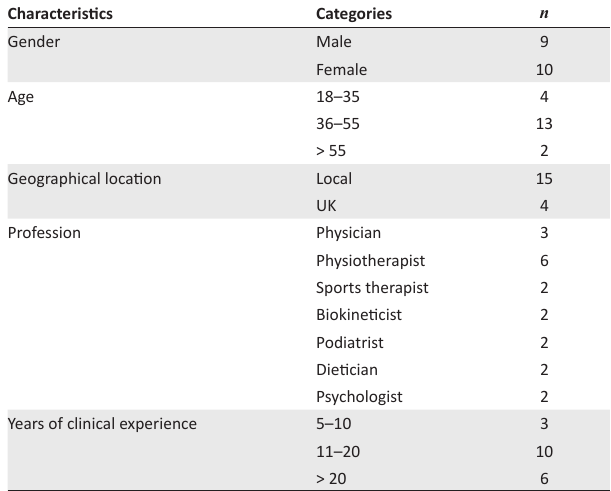
TABLE 1: Demographic profile of participants ( n = 19).